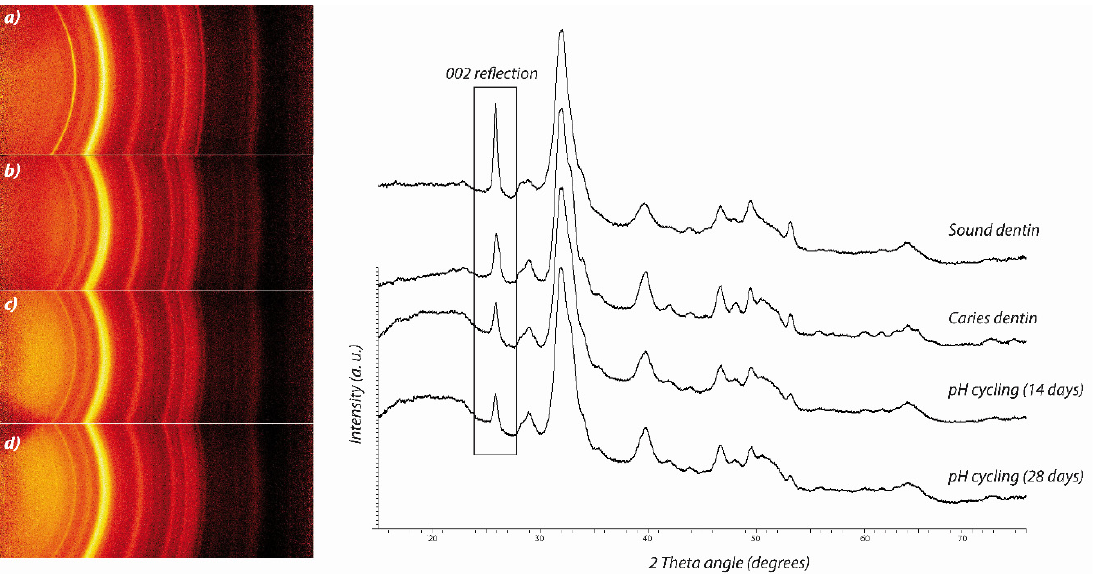
Figure 5. 2D-XRD patterns and integrated 2Theta scan: ( a ) sound dentine, ( b ) carious dentine, ( c ) pH cycling (14 days), and ( d ) pH cycling (28 days). The (002) diffraction peak considered for the crystallite size measurements is indicated in the unidimensional patterns.